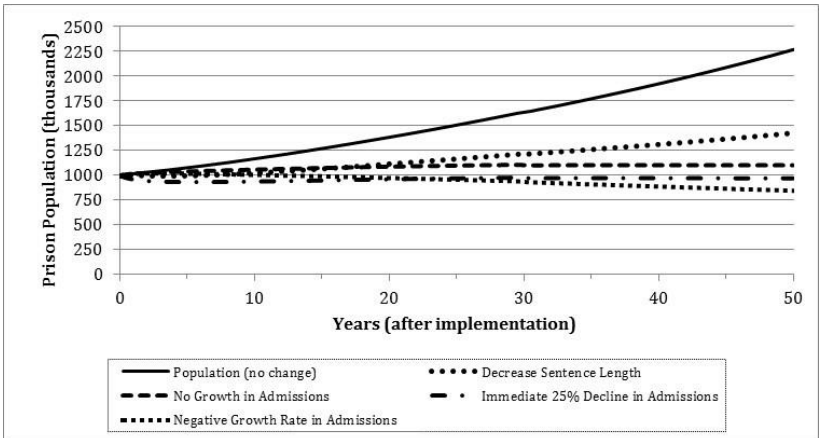
Figure 3. Complete Inmate Population, Changes in Policies for Nonviolent Offenders and Violent Offenders. Source: Calculations by author using Bureau of Justice Statistics data.